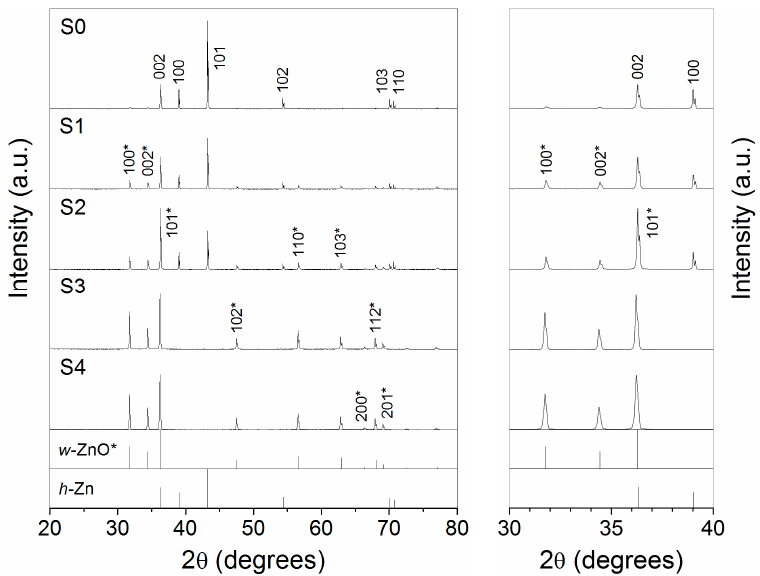
Figure 1. Left : X-ray patterns of the precursor powder (S0) and the products obtained after its thermal oxidation (900 ° C; air atmosphere) during different times: 3 (S1), 6 (S2), 12 (S3), and 24 min (S4). Right : detail of the X-ray peaks observed at the smallest diffraction angles. The position and relative intensity of the X-ray reflections reported for w-ZnO and h-Zn are shown for reference. Table 1. Diffraction angle (2 θ ), calculated interplanar distance ( d ), and full width at high maximum (FWHM) of the X-ray peaks observed in the diffractograms of the samples obtained by thermal oxidation. The crystallographic data of the h-Zn (JCPDS #004–0831) and w-ZnO (JCPDS #036–1451) structures are given for comparison.